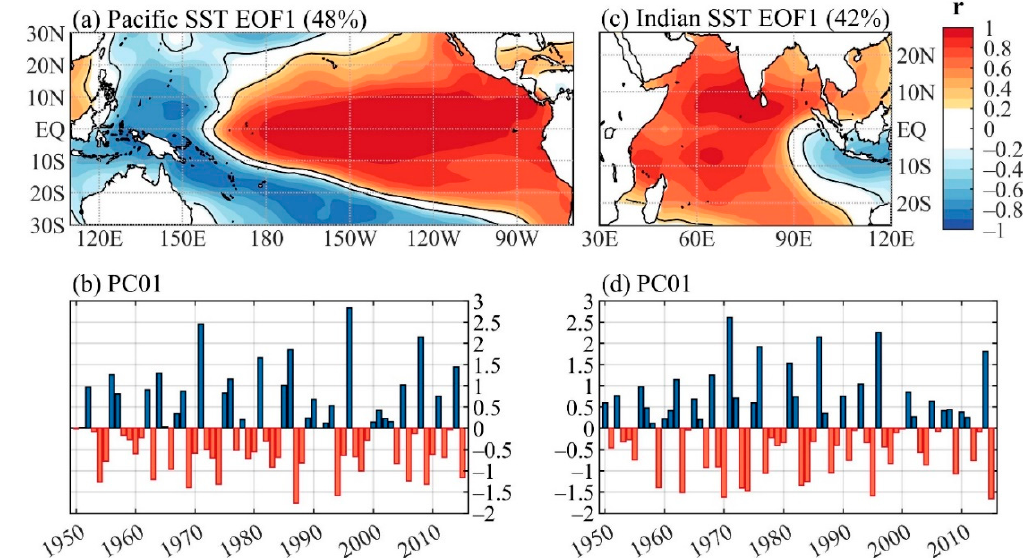
Figure 2. Spatial loading pattern and principal component (PC) time series of first EOF mode the interannual SST anomalies during the southern springs of the 1951–2016 period for the: ( a ) tropical Pacific Ocean; ( b ) PC for the tropical Pacific loading pattern; ( c ) tropical Indian Ocean; and ( d ) PC for the tropical Indian Ocean loading pattern. Continuous contours encompass the significant correlations at a 95% confidence level using the Student’s t -test.